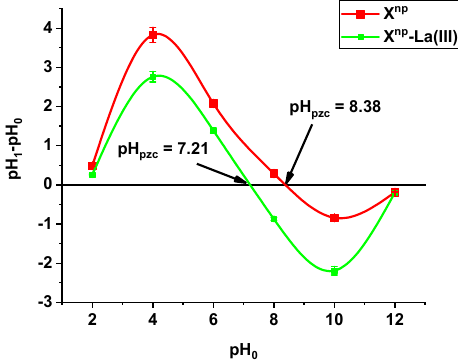
Figure 1. pH pzc measured by the drift method for X np before and after La(III) adsorption. The SEM images of the raw and lanthanum-modified sorbent are presented in Figure 2.